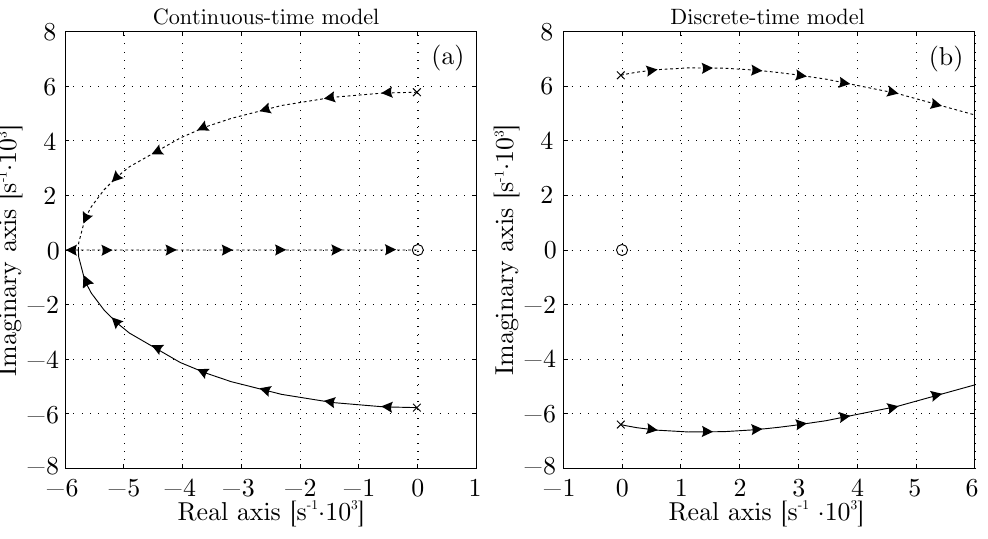
( s ) and ( b ) F ( z ) , shifting the value of K i i